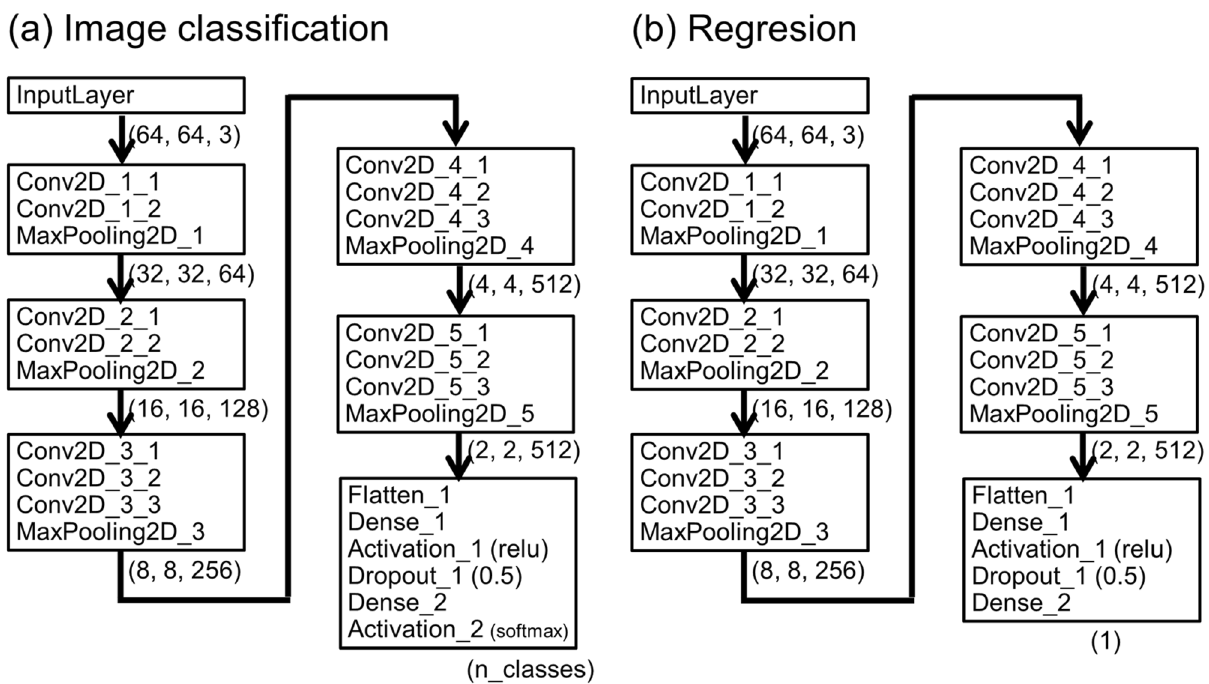
Figure 8. Schematic images of network architectures for ( a ) image-classification problem and ( b ) regression problem based on the VGG-16 model. The first five convolutional blocks are the same, but the last block is different. For the image-classification problem, the output is a vector whose number of elements equals the number of classes. For the regression problem, the output is a scalar. Here, the numbers at the lower right of each block denote the number of elements of the output tensor of each